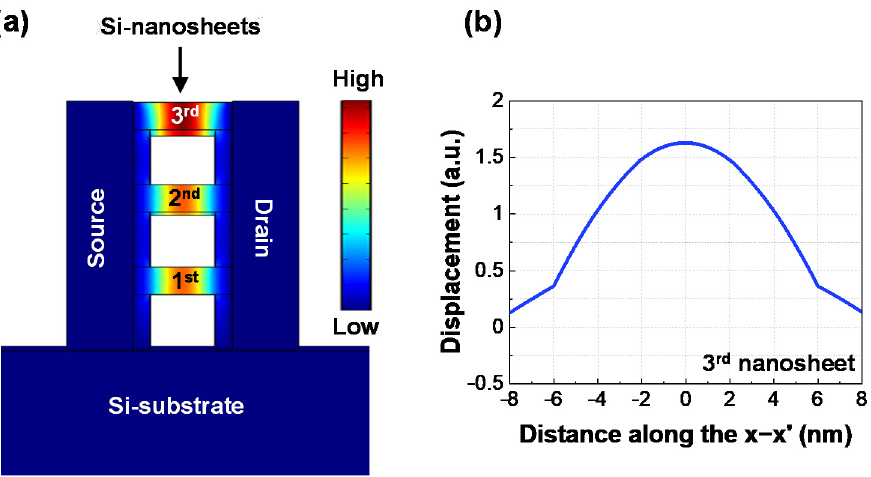
Figure 3. ( a ) Simulated mechanical displacement profiles from Figures 1e and 2. ( b ) Extracted mechanical displacement along the x–x’ direction.